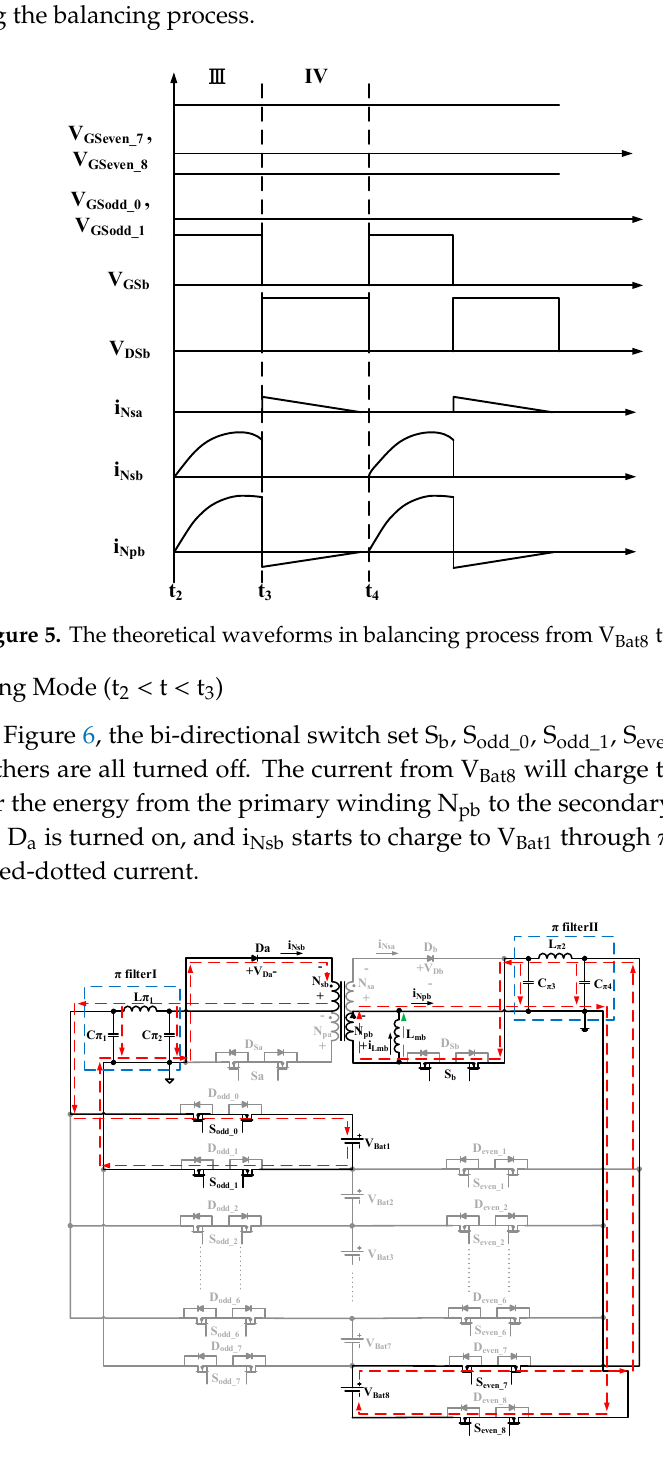
Figure 6. Mode III, the battery balancing process from higher V Bat8 to lower V Bat1 .